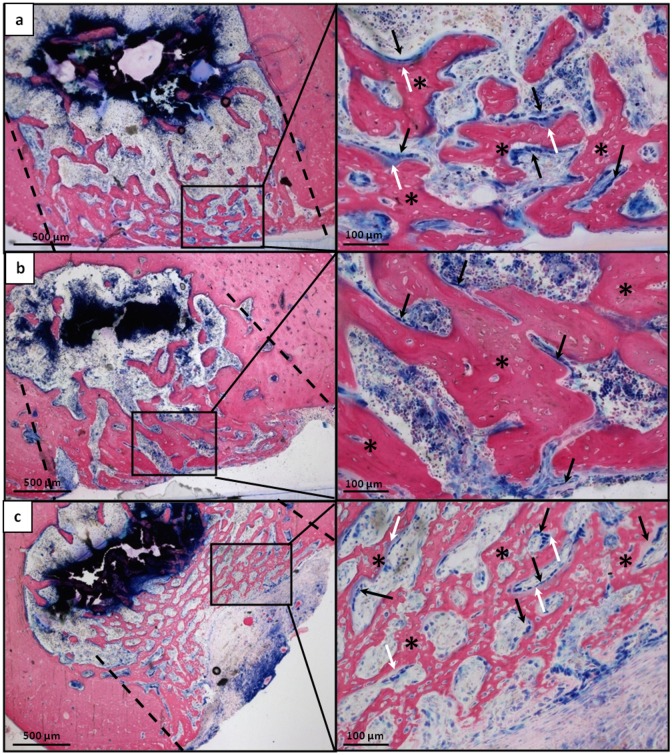
Histological microphotographs of femoral sections at the lesion site 15 days after implantation.
a) Unfilled defect; b) Pluronic F127 filled defects; c) DBM-PF127 composite filled defects. Sections were stained with Stevenel’s/Van Gieson stain. In the left column the entire transversal section passing through the lesion is shown, in the right column high magnification of a portion of right column images is shown. Dashed line indicate the defect edges, (*) indicate the newly formed bone, Black arrow indicate osteoblast cells and white arrow indicate osteoid.